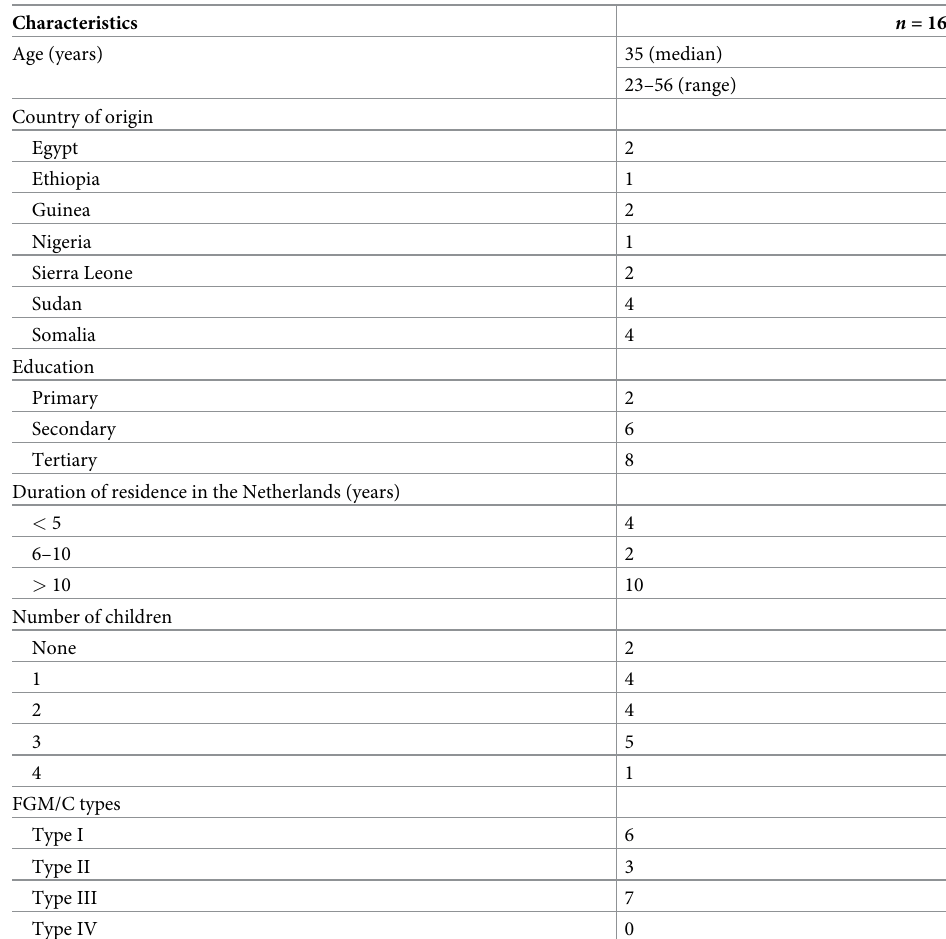
Table 1. Characteristics of study